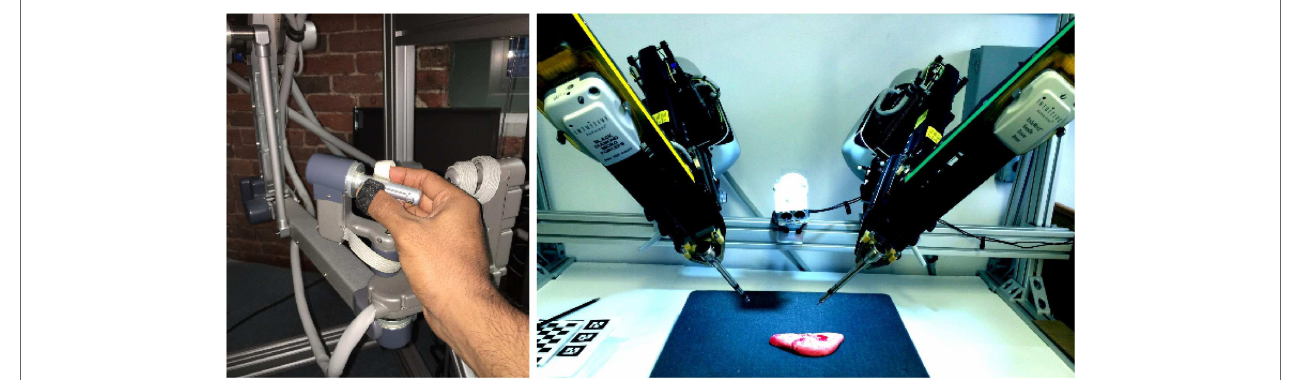
FIGURE 1 | MTM on the left and the two PSMs on the right . dVRK setup at AIM Lab,